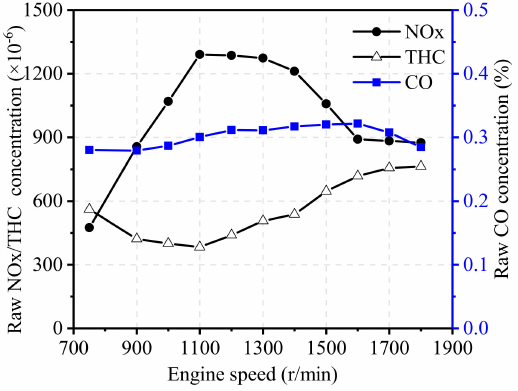
Figure 7. E ff ect of engine speed on exhaust